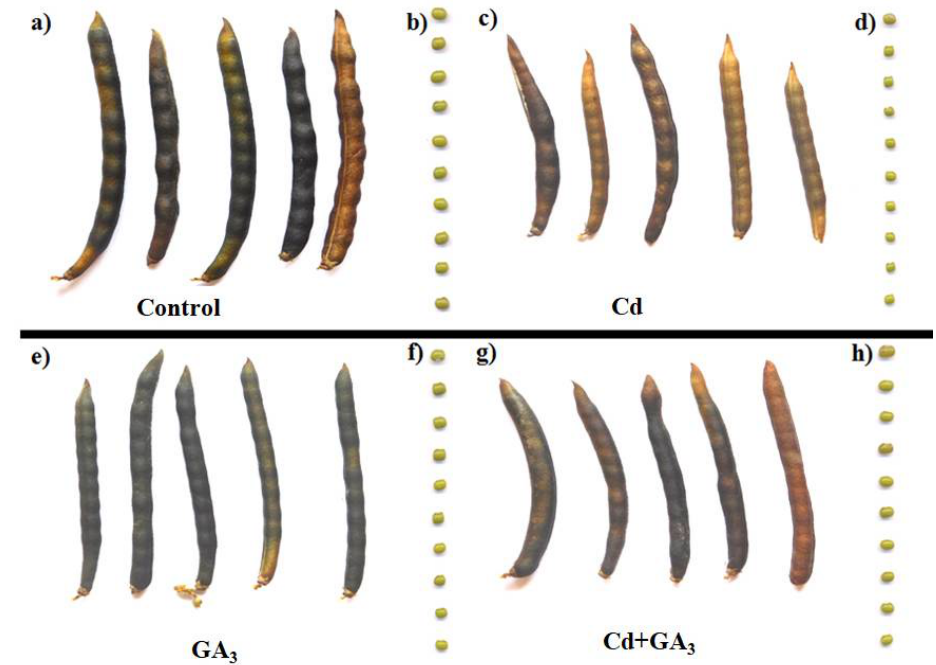
Figure 5. Effect of GA 3 on the relative gene expression of Vigna radiata phytochelatin synthase 1 ( VrPCS1 ), ( a ), VrIron transporter 1 ( VrIRT1 ) ( b ), VrIron transporter 2 ( VrIRT2 ) ( c ) and Vr cadmium response ( VrCDR29 ) ( d ) in young seedlings subjected to Control (CN), cadmium (Cd) stress, Cd+ gibberellins (GA 3 ), and GA 3 alone conditions in paper roll method. Data presented are means ± standard errors ( n = 3, biological replicates).